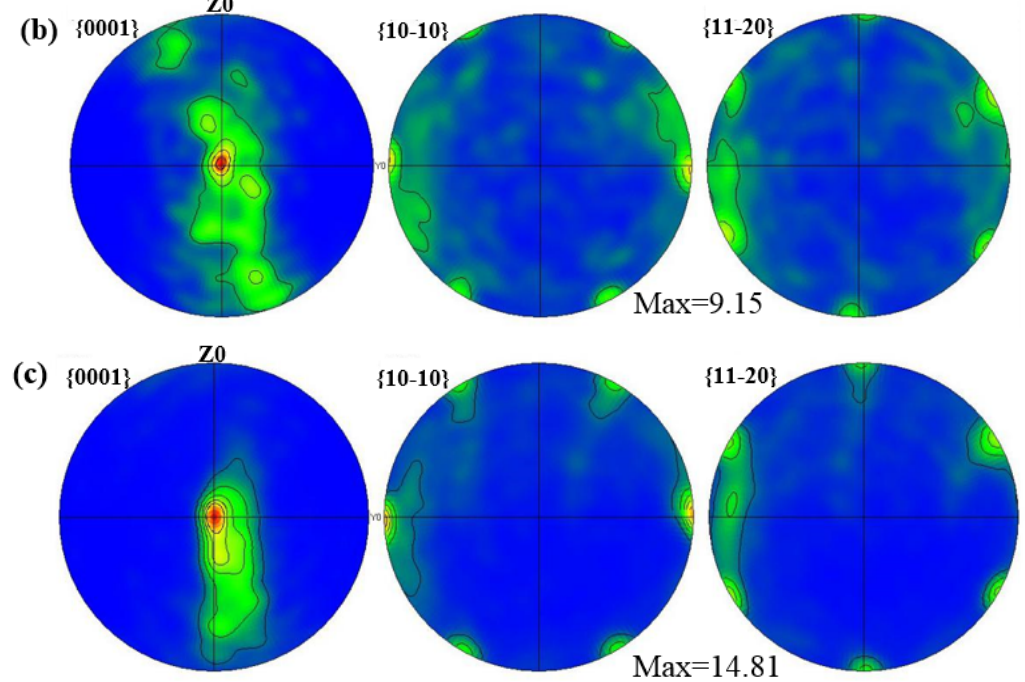
Figure 6. The texture strength of extruded AZ31-xCaO alloys. ( a ) AZ31; ( b ) AZ31-0.5%CaO; and, ( c ) AZ31-1%CaO.